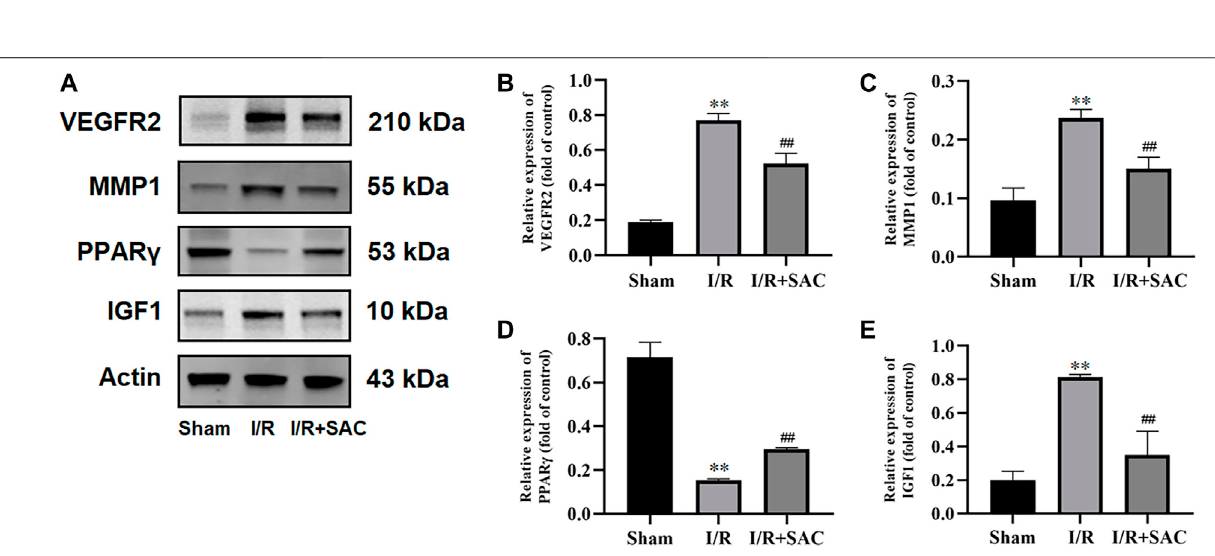
Frontiers in Pharmacology |